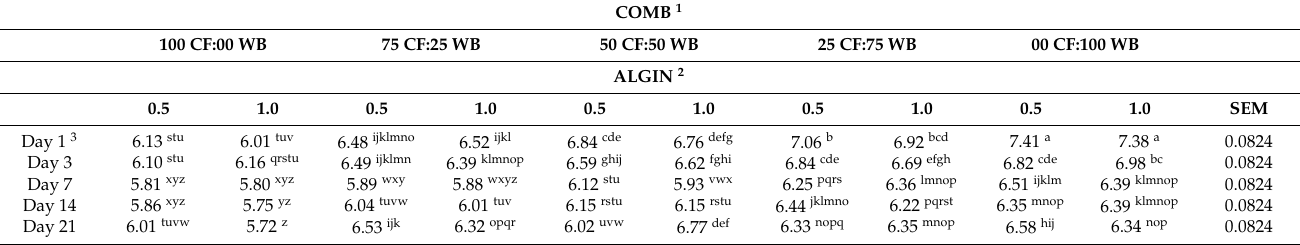
Table 6. Interactive effect of COMB × ALGIN × DAY on pH of pet food formulations during a simulated retail display. COMB